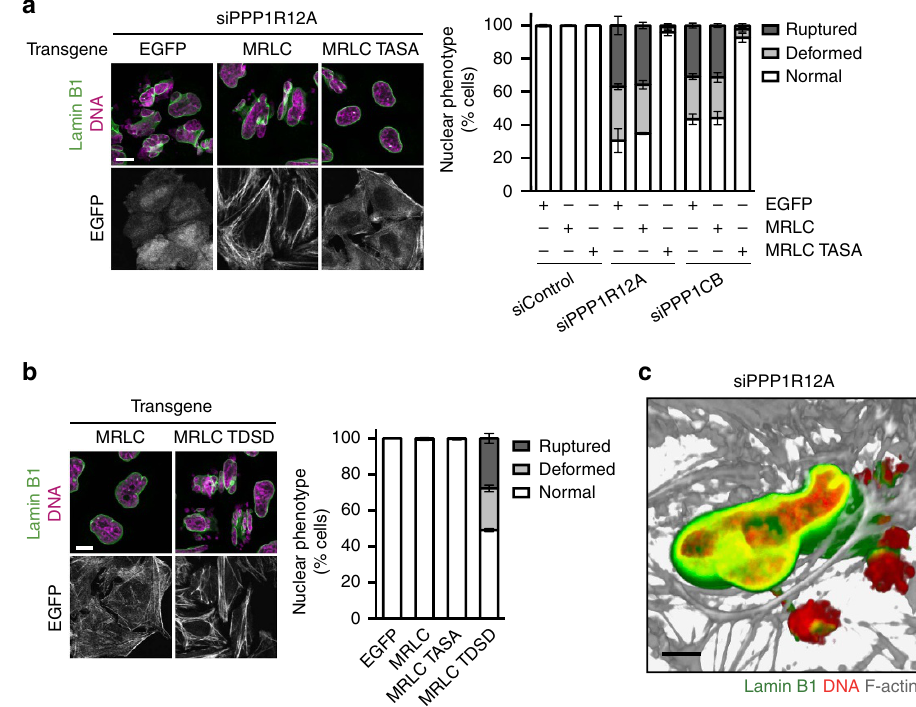
Figure 3 | Deregulation of MRLC phosphorylation causes ectopic actomyosin fibre formation and nuclear deformation. ( a ) HeLa Kyoto cells were transduced with lentiviral particles encoding EGFP, MRLC-EGFP wildtype or MRCL-EGFP T18A S19A (TASA). 15h after infection, cells were transfected with the indicated siRNA duplexes and processed for immunofluorescence analysis 56h after transfection. Only EGFP signal-positive cells were scored. Representative cell images (left panel) and quantification of nuclear phenotype (right panel) are shown. ( b ) HeLa Kyoto cells were infected with lentiviral particles encoding MRLC-EGFP wildtype or a T18D S19D mutant (TDSD) and processed for immunofluorescence analysis 56h after infection. Only EGFP signal-positive cells were scored. Representative cell images (left panel) and quantification of nuclear phenotype (right panel) are shown. ( c ) PPP1R12A-depleted cells were fixed and stained for with anti-lamin B1 antibodies, DAPI and fluorophore-conjugated phalloidin. Cells were scanned in 0.1 m m sections using confocal laser scanning microscopy. The 3D image was reconstituted and rendered using Imaris software. Error bars, s.d. of three independent experiments ( n 4 200 cells each) ( a , b ). Scale bars, 10 m